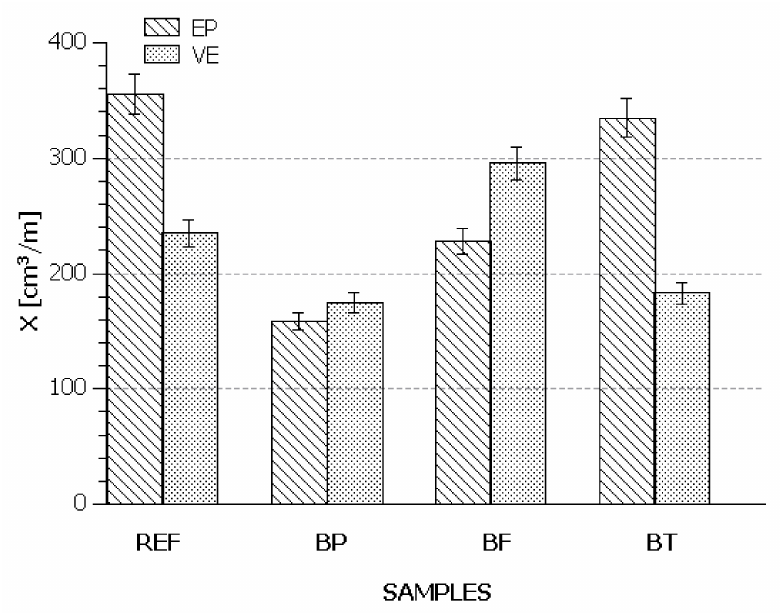
Figure 18. Abrasion of EP and VE composites reinforced with basalt powder (BP), basalt fibre (BF) and basalt textile (BT).